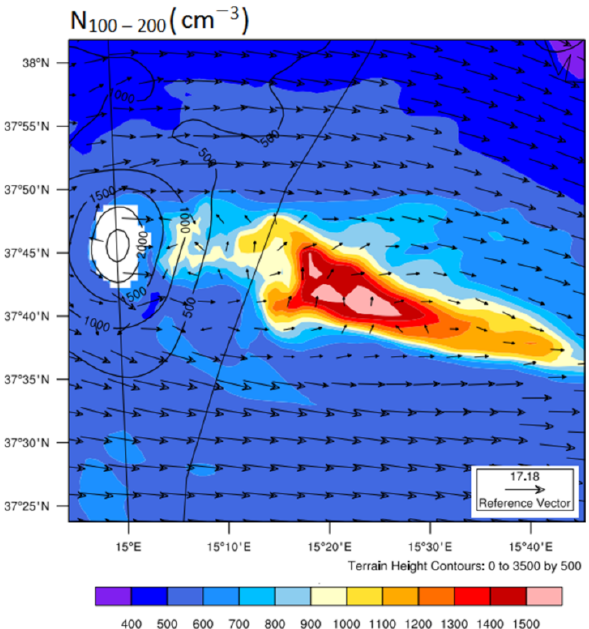
Figure 7. The same as Figure 3b,d, but for CCN-sized particles (N 100–200